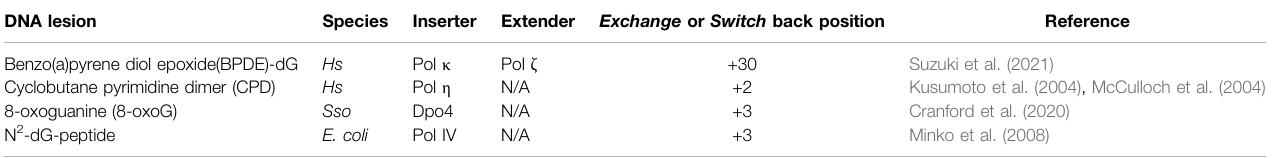
TABLE 1 | The position of substitution back to high fi delity synthesis. DNA lesion Species Inserter Extender Exchange or Switch back